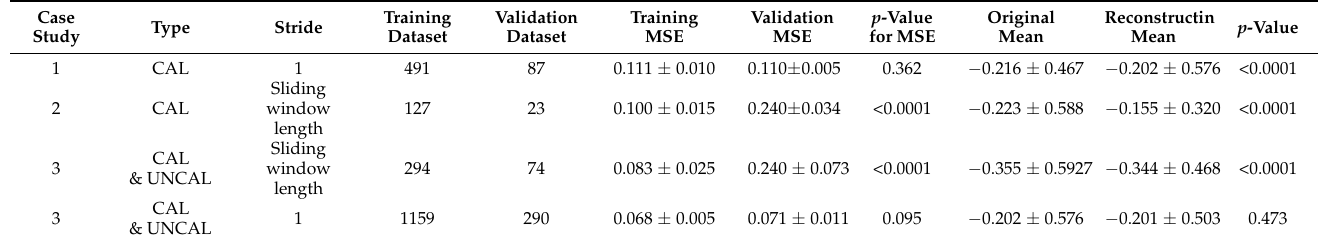
Figure 11. ( a ) A sample 3D calendered mini microstructure with size 4 × 224 × 224 ( b ) Reconstructed 3D microstructure from the 3-layer 3D CAE trained on the calendered plus uncalendered dataset created with a sliding window length = 4 and stride = sliding window length. Table 8. Evaluation of training and validation MSE of 3-layer 3D CAEs trained with calendered and uncalendered mini microstructures in 3 case